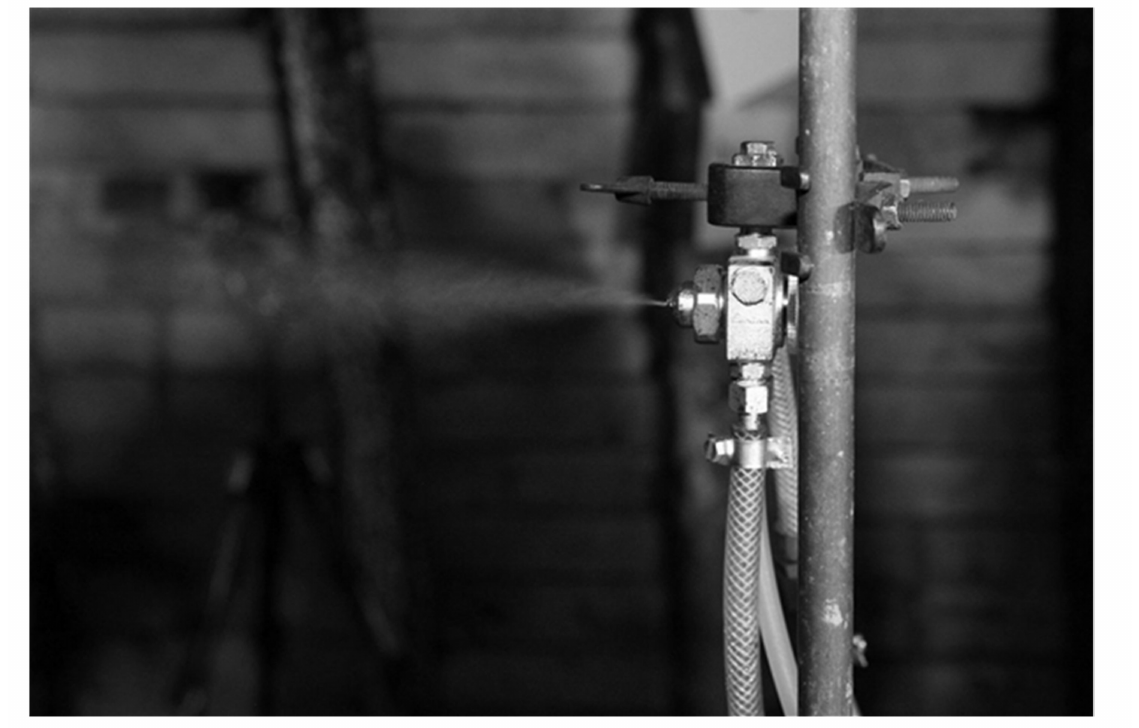
Figure 4. Nozzle during aerosol generation.